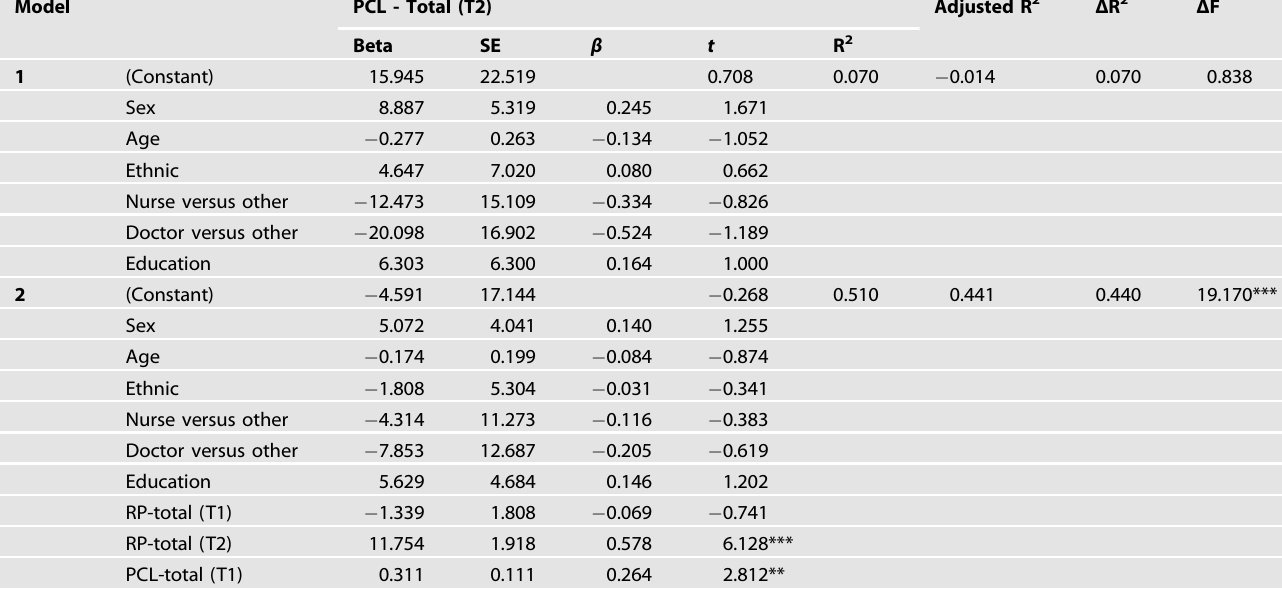
Table 2. Regression analysis with the total score of PCL-5 of HCWs in T2 as the outcome variable.